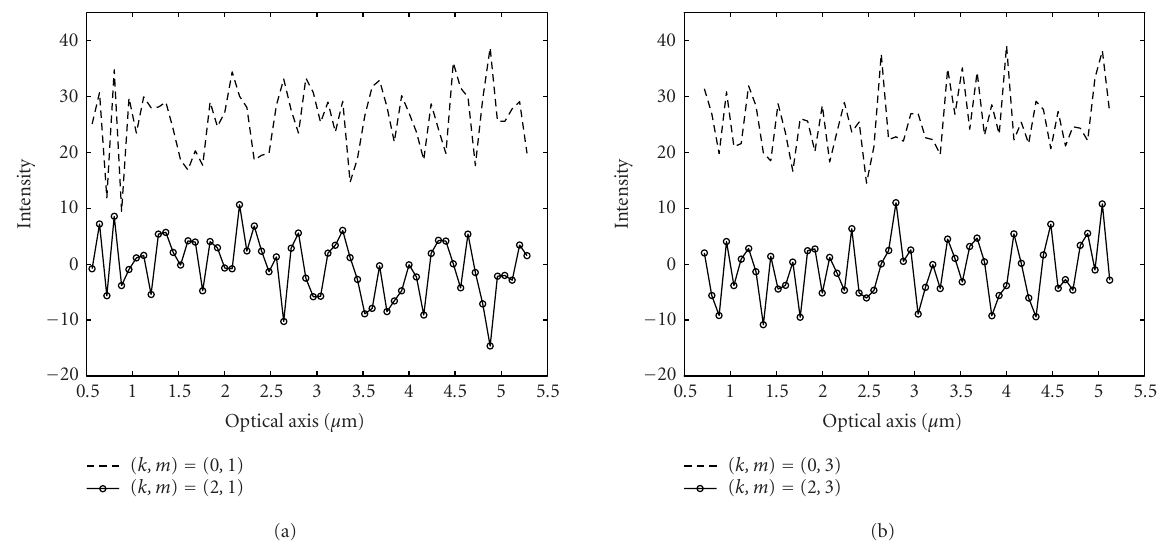
Figure 9: DEO applied to a white noise signal with 5.0 standard deviation: (a) Ψ 01 and Ψ 21 and (b) Ψ 03 and Ψ 23 .